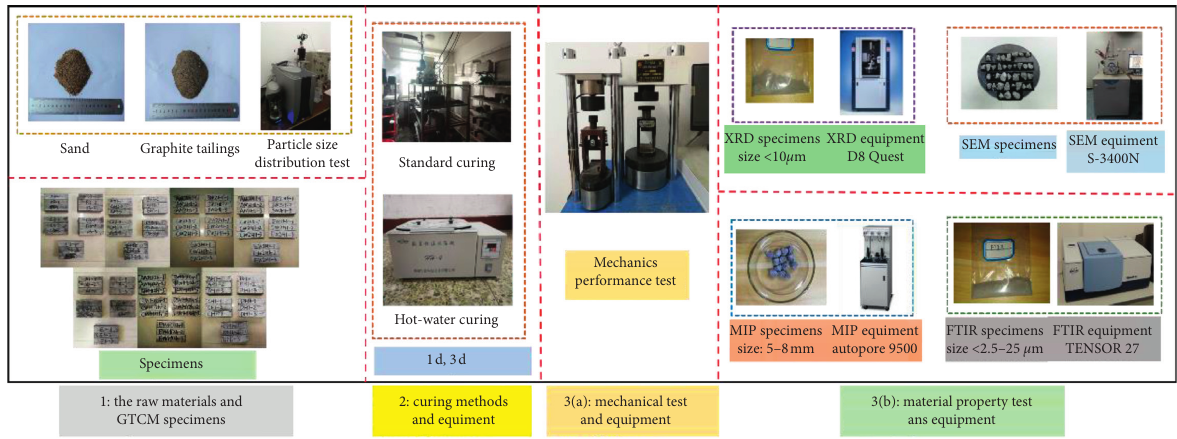
Figure 1: Flowchart of experimental methods.